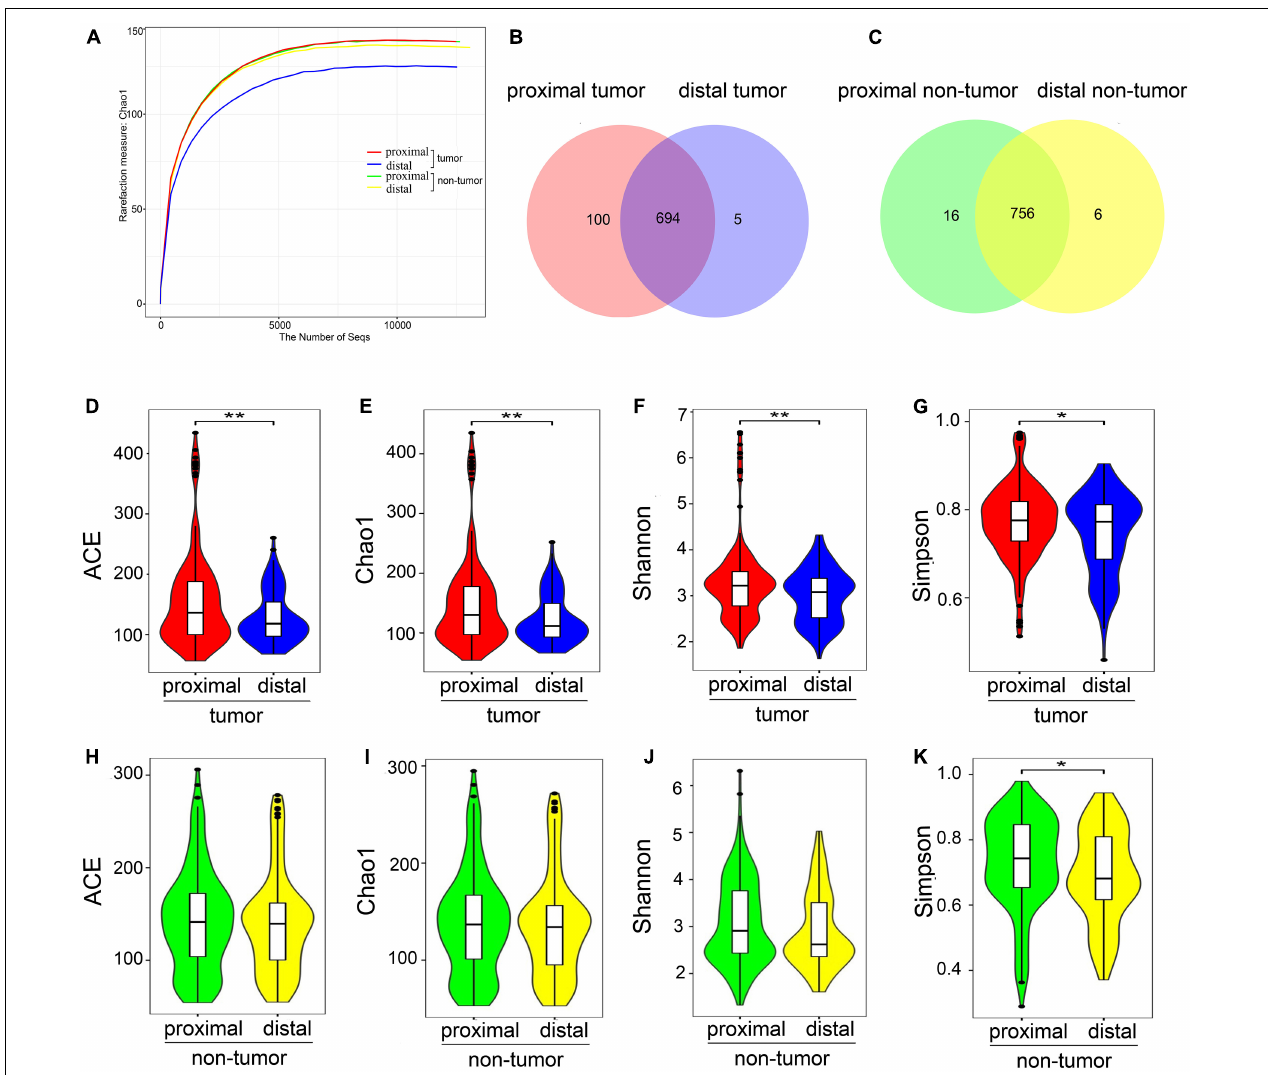
FIGURE 2 | Microbial community richness and diversity in proximal and distal CRC tumor tissues. (A) Rarefaction curves between the number of sequences and estimated richness by Chao1. The sequencing depth basically approached saturation in all samples. (B) Venn diagrams. The Venn diagrams represent the shared and unique taxa among the different tissues. One hundred of 799 OTUs were unique for proximal tumor tissues compared with distal tumor tissues, while only 16 of 778 OTUs were unique for proximal non-tumor tissues compared with distal non-tumor tissues (C) . The microbial diversity, as estimated by the ACE index (D) , Chao1 index (E) , Shannon index (F) , and Simpson index (G) , was significantly higher in proximal tumor tissues than in distal tumor tissues ( p = 0.0062, 0.0058, 0.0074, and 0.0125, respectively). There were no significant differences in ACE (H) , Chao1 (I) , and Shannon indices (J) , between proximal and distal non-tumor tissues ( p = 0.4764, 0.4852, and 0.1218, respectively) except the Simpson index (K) ( p = 0.0125); CRC, colorectal cancer; OTUs, operational taxonomic units. * p < 0.05; ** p <